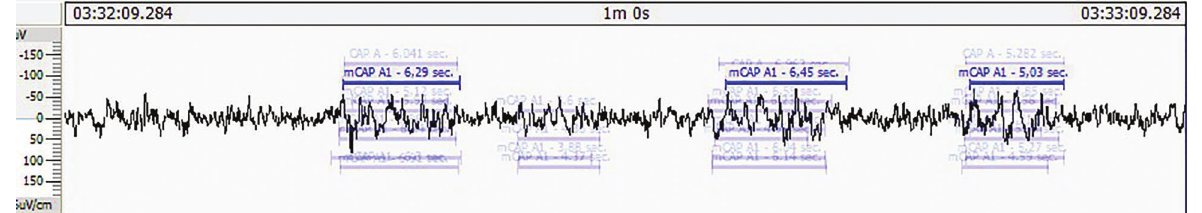
Figure 6. Box plot with all fi les inter-scorer mutual agreement with scorer Z. The boxes are between 1st and 3rd quartile. The interquartile range is between 20 and 50%. The line inside is the median. Scorers: vz, az, gz, nz, pz, qz, xz, and yz.